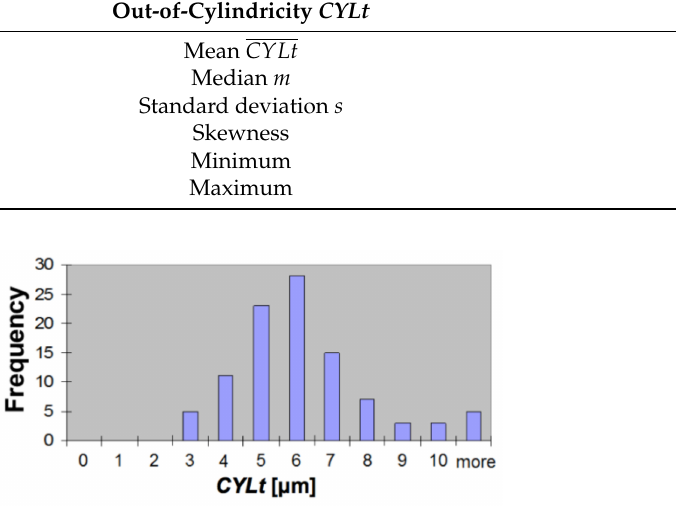
Figure 9. Histogram of cylindricity deviation CYLt